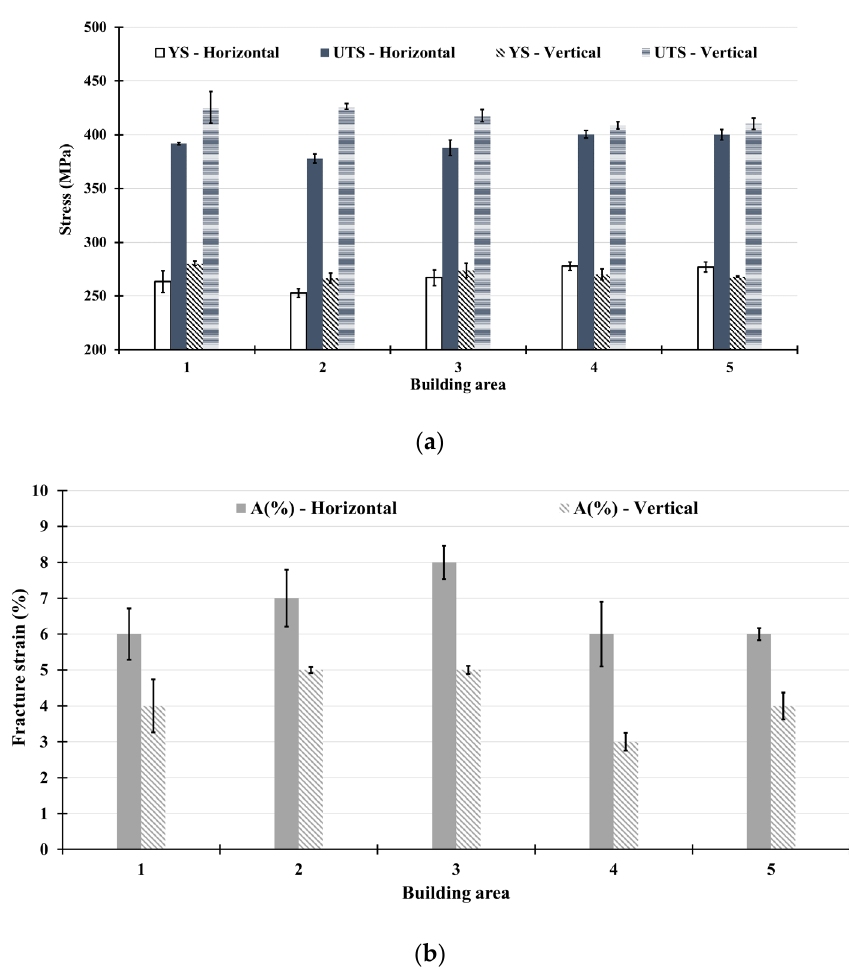
Figure 4. ( a ) Evolution of yield strength, ultimate tensile stress, and ( b ) fracture strain as a function of building area. For each building area and orientation, plotted values resulted from three speci- mens tested.